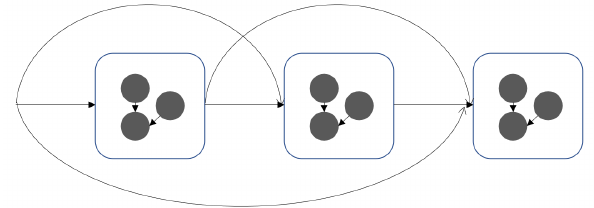
Figure 4. Dense connected architecture of Densely Connected